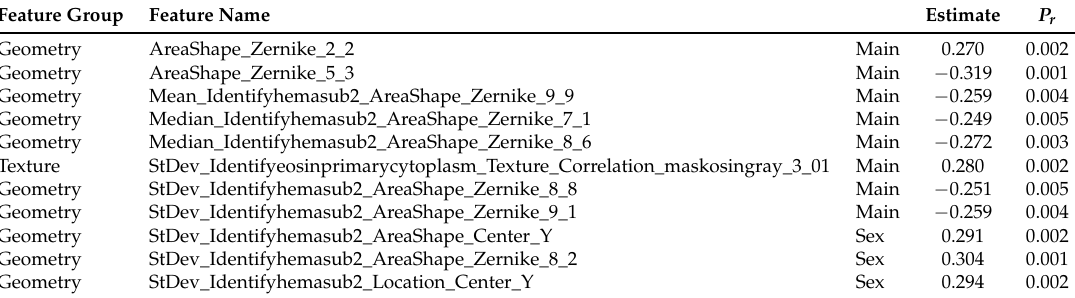
Table 1. Marginal analysis of the reference value for the pre-bronchodilator forced expiratory volume in one second in percent (FEV1): identified main effects and interactions, with raw p -values P r . Feature